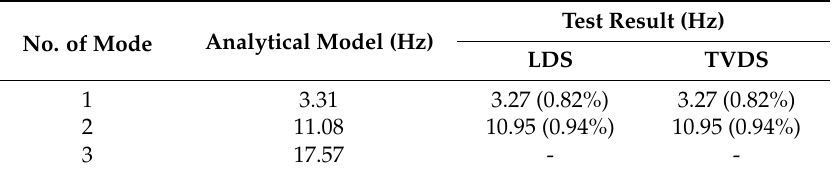
Figure 11. Comparison of natural frequencies obtained from the TVDS and LDS according to the floor level. ( a ) 1st floor; ( b ) 2nd floor; ( c ) 3rd floor. Table 3. Experimental and analytical natural frequencies of the scaled model.